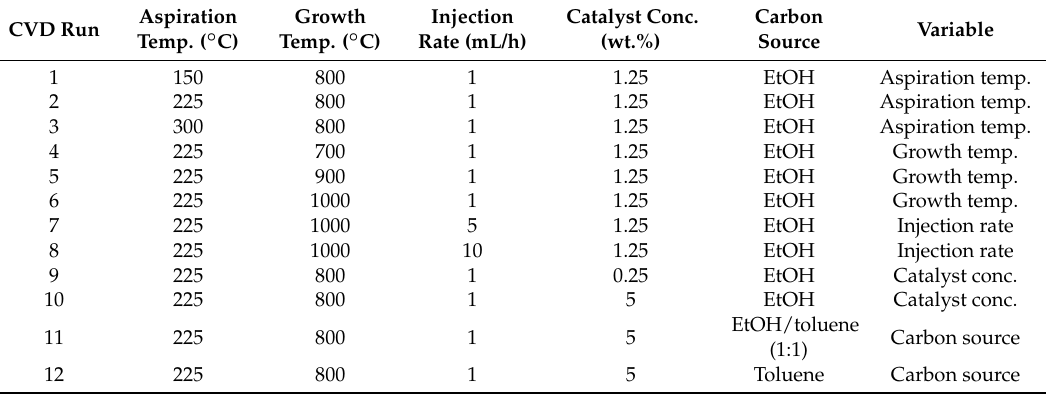
Table 2. Summary of direct liquid injection chemical vapor deposition (DLICVD) experiments where temperature and concentration are abbreviated as temp. and conc.